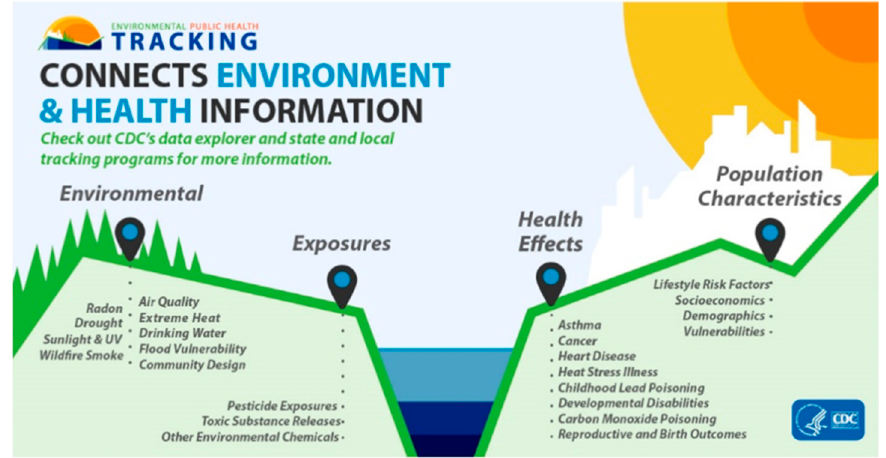
Figure 4. Environmental Health topics investigated by the US EPHT [31].